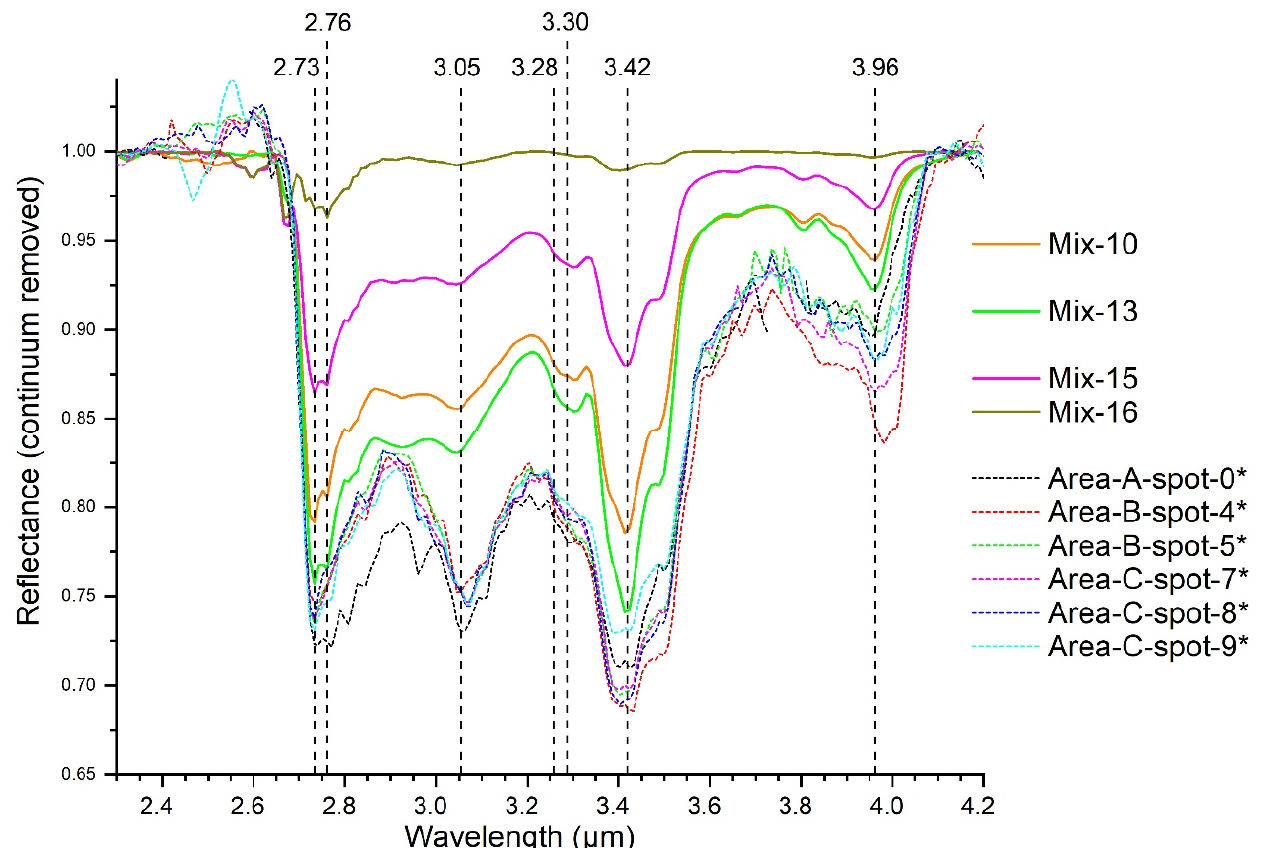
Figure 7. Reflectance spectra after continuum removal of laboratory mixtures 10-13-15-16 between 2.5–4.2 µm compared with carbon-rich VIR spectra from Ceres in the Ernutet and Hakumyi areas (*with photometric reduction, see Methods and Analyses section). Impact of the quantity and nature of the darkening agent can be observed on the spectra of these mixtures.